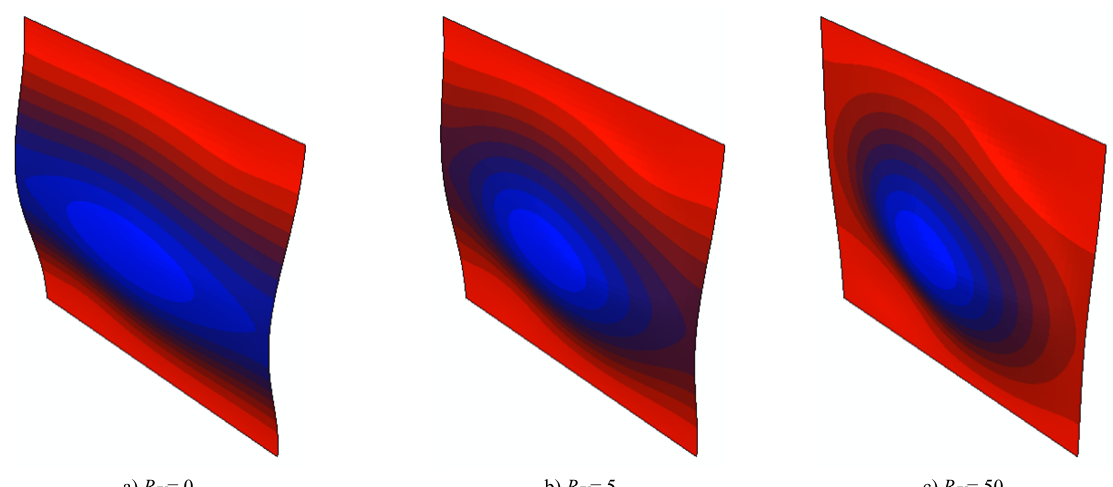
Fig. 6 FE fundamental buckling shapes for glass shear walls supported by metal frames with variable out-of-plane bending stiffness